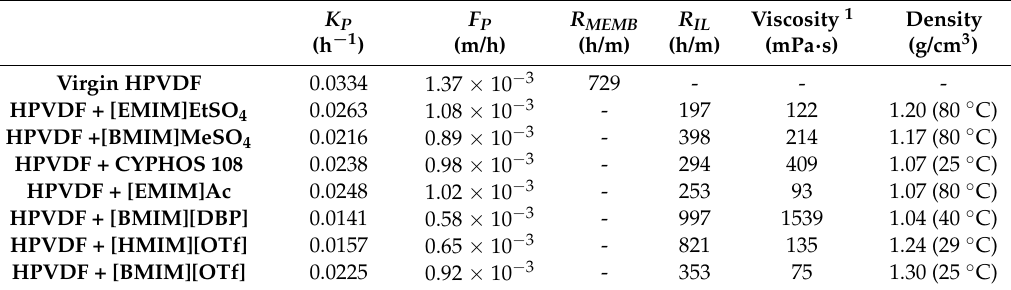
Table 2. Values of effective mass transfer constants K P , permeate fluxes F P , and resistances (attributable to the membrane support and the IL) for virgin HPVDF membranes and SILMs based on these membranes (viscosity and density values of the ILs are